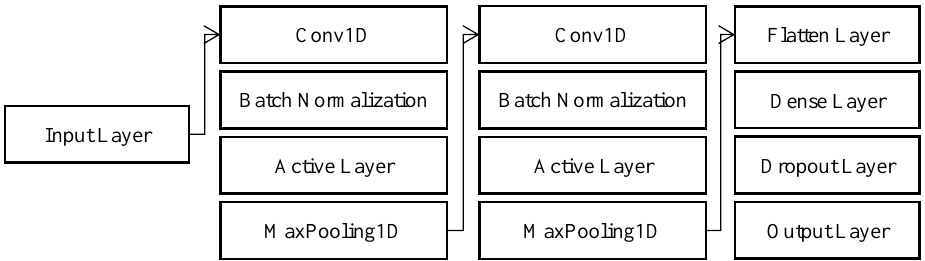
Fig. 2. Hierarchical structure of 1D-CNN feature fusion and extraction